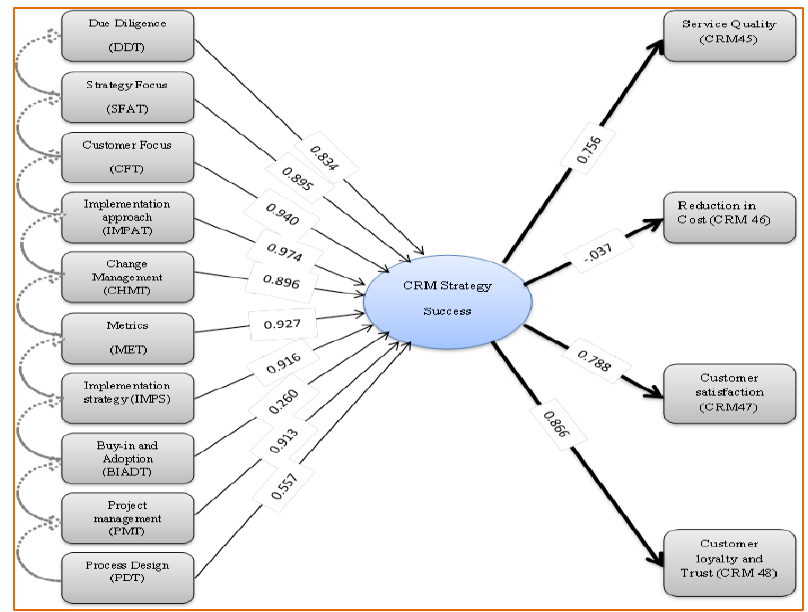
Figure 1: The Final Conceptual Model of the Critical Success Factors in CRM Strategy Success; Source: Author.